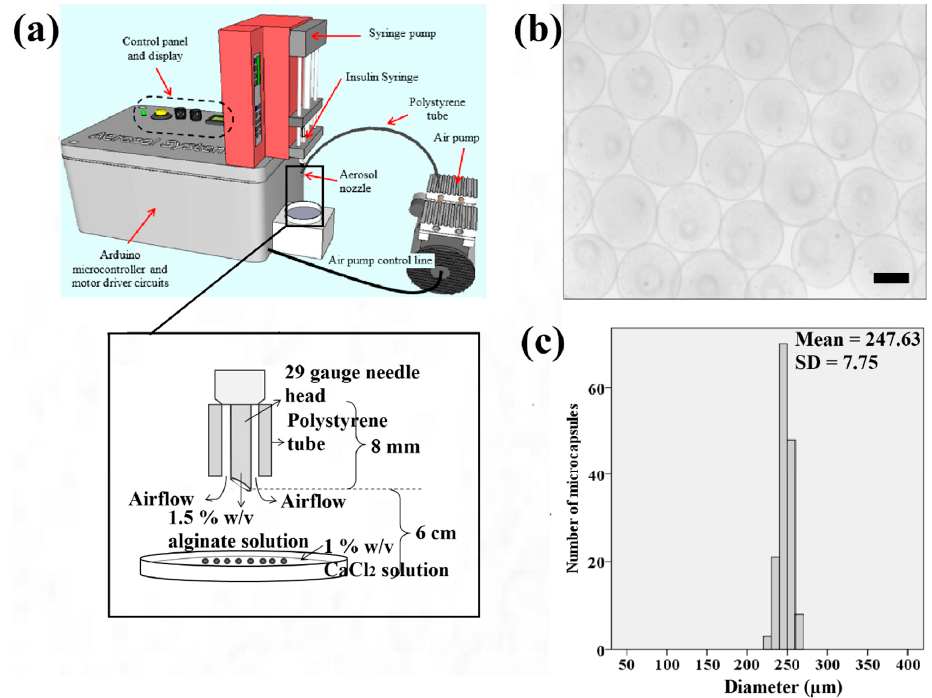
Figure 1. ( a ) Schematic illustration of the electronic aerosol microencapsulation system; ( b ) The